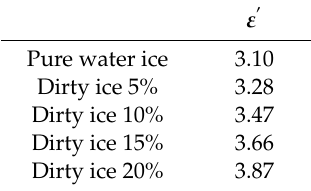
Table 1. Real part of complex relative permittivity for di ff erent materials, constituents of